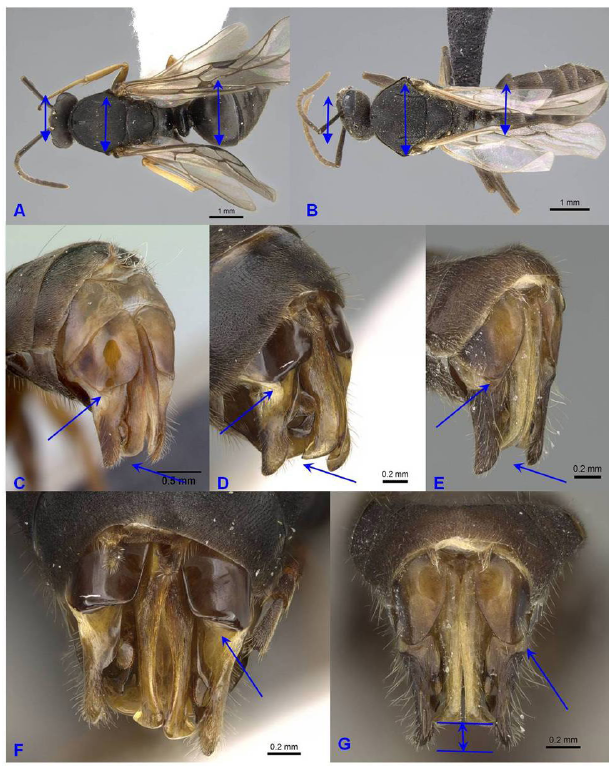
Fig 4 . Dorsal view of Formica gerardi (A) [XE00205-3] and Iberoformica subrufa (B) [KG030006-4]. Detail of genitalia of Formica fusca (C) [CASENT0178770], Formica gerardi (D, F) [XE00205-3] and Iberoformica subrufa (E, G) [KG030006-4]. Images from www.antweb.org